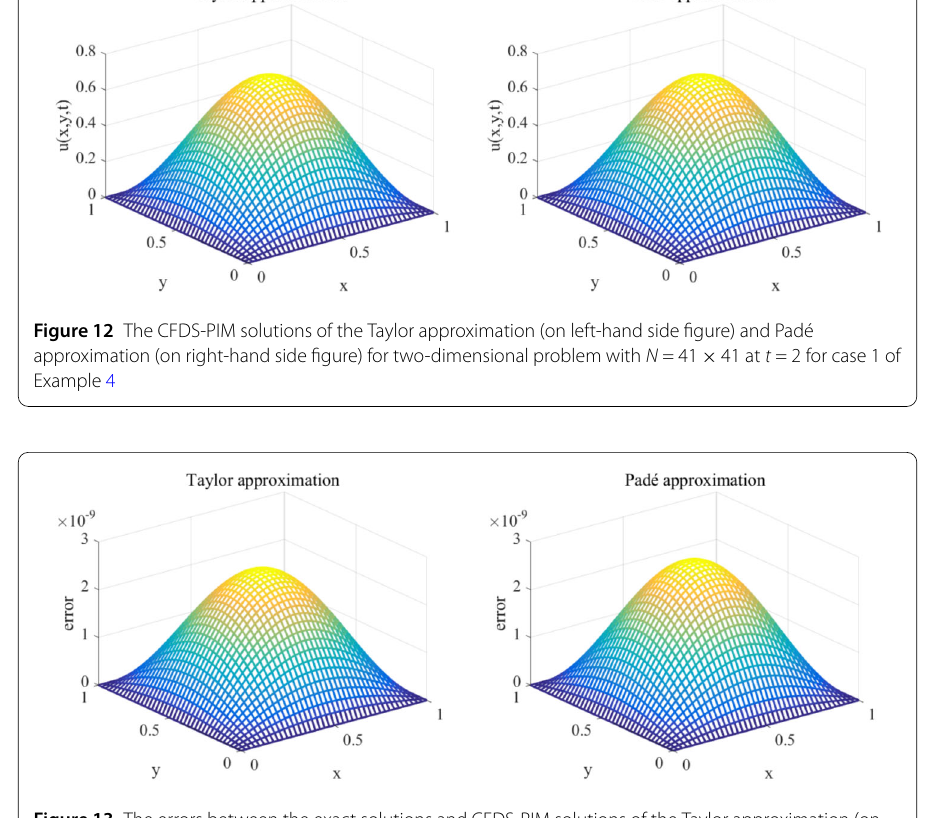
Figure 13 The errors between the exact solutions and CFDS-PIM solutions of the Taylor approximation (on left-hand side figure) and the error between the exact solutions and the CFDS-PIM solutions of Padé approximation (on right-hand side figure) for two-dimensional problem with N = 41 × 41 at t = 2 for case 1 of Example 4